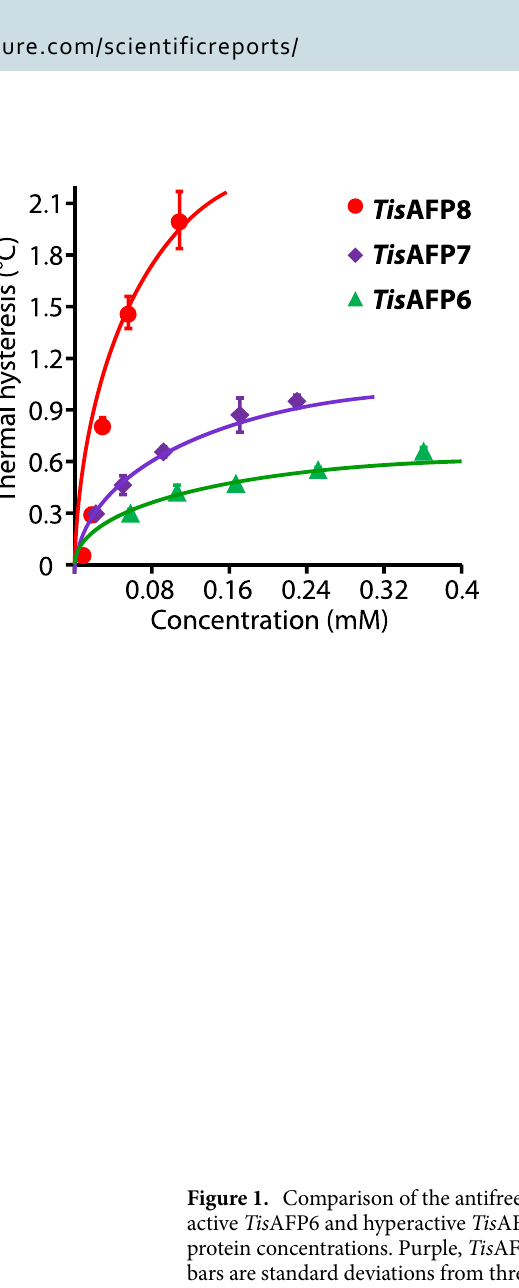
Figure 1b presents micro-